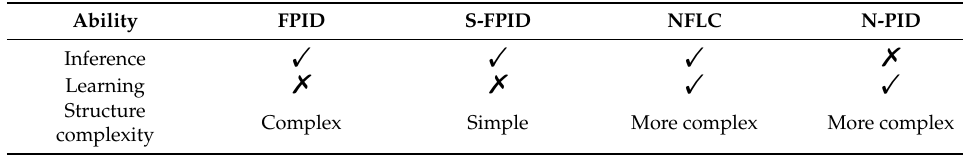
Figure 13. Structures of NFLC and neuro-PID: ( a ) NFLC structure, ( b ) N-PID structure. Table 5. Comparison of four kinds of intelligent controller.